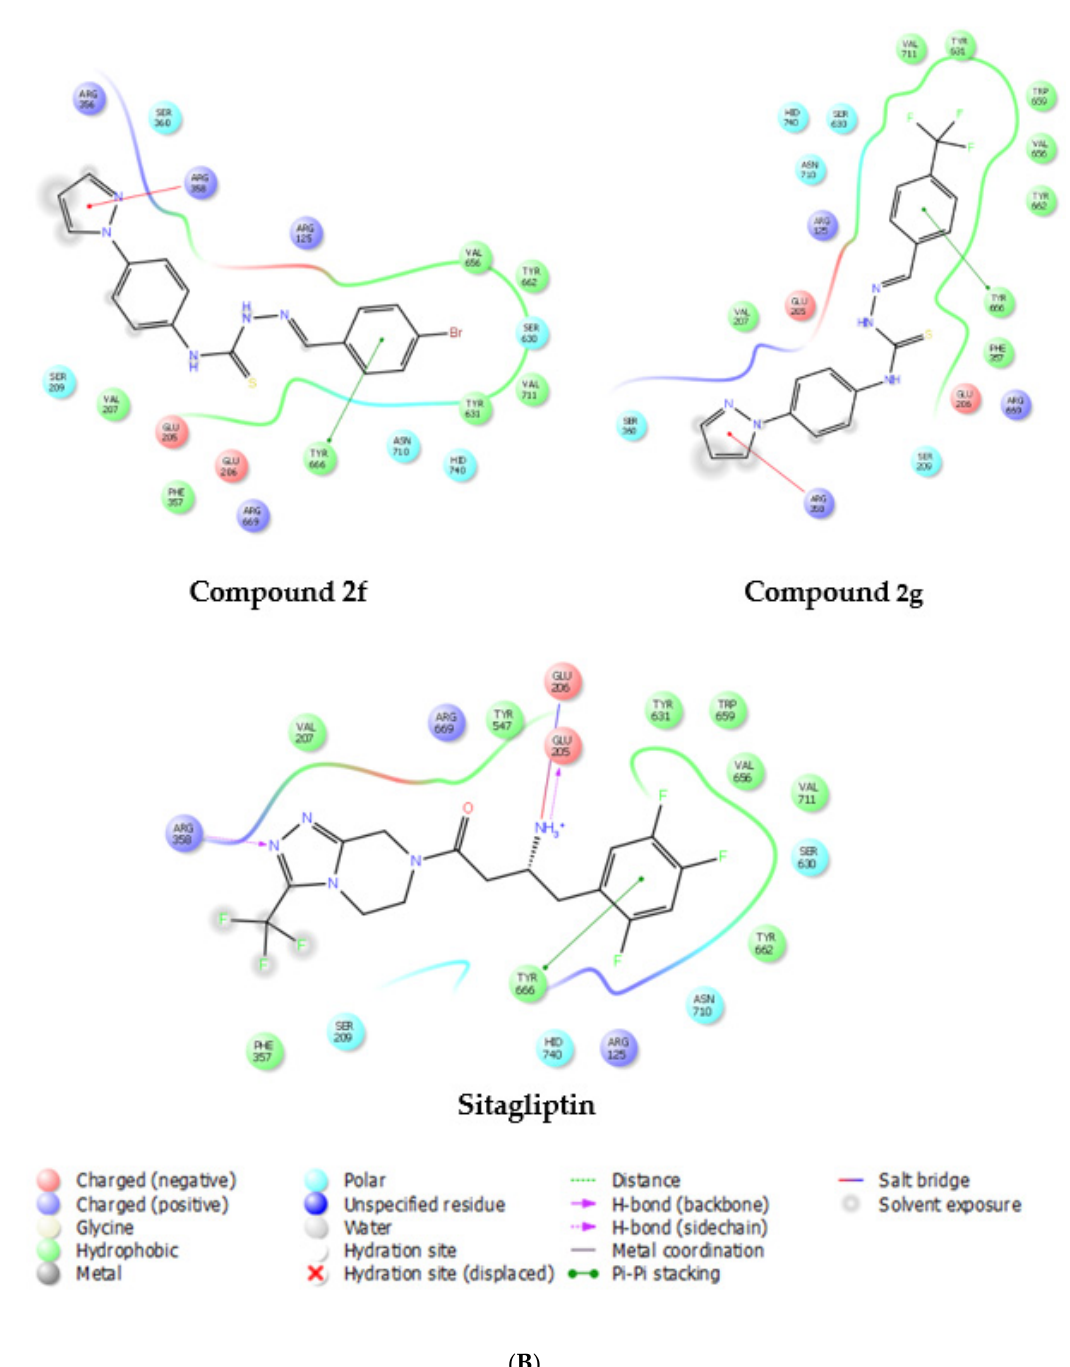
Figure 6. Docking poses of compounds 2f and 2g along with sitagliptin ( A ) and docking interactions of compounds 2f and 2g ( B ) in the active site of DPP-4 (Blue and green dashes: π - π interactions, yellow dashes: hydrogen bonding).